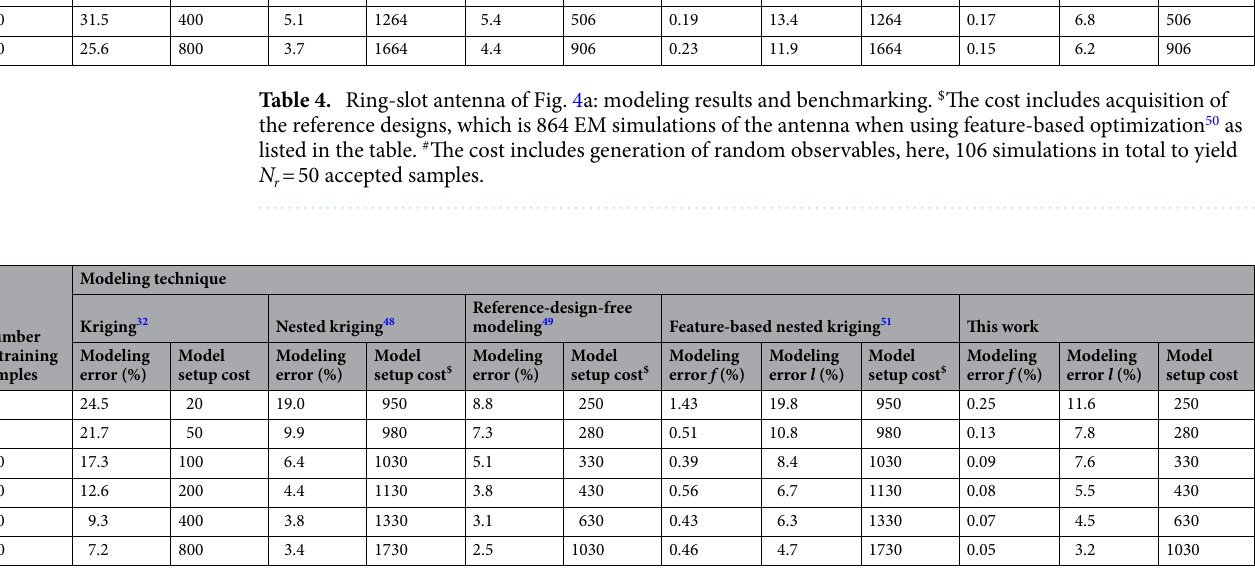
Table 5. Dual-band antenna of Fig. 4b: modeling results and benchmarking. $ The cost includes acquisition of the reference designs, which is 930 EM simulations of the antenna when using feature-based optimization 50 as listed in the table. Conventional (minimax) optimization required 1201 simulations. # The cost includes generation of random observables, here, 230 simulations in total to yield N r = 50 accepted samples.